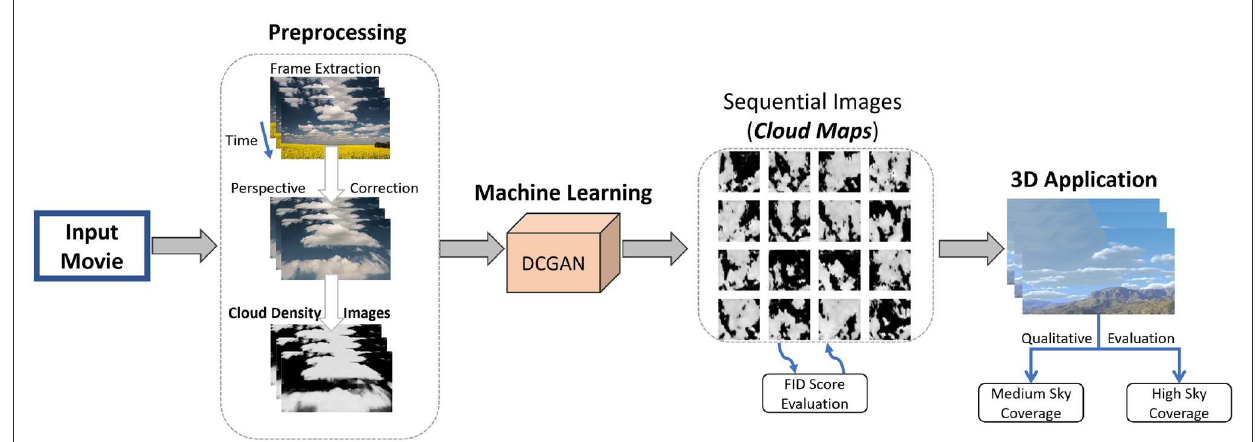
FIGURE1 Overview of our method. In the preprocessing stage, input video frames are extracted and cropped for regions containing cloud animation. Subsequently, we applied other corrections to produce density cloud images, which are given as input to the DCGAN for learning. The output of DCGAN is the sequential cloud images, which are plugged into a 3D rendering